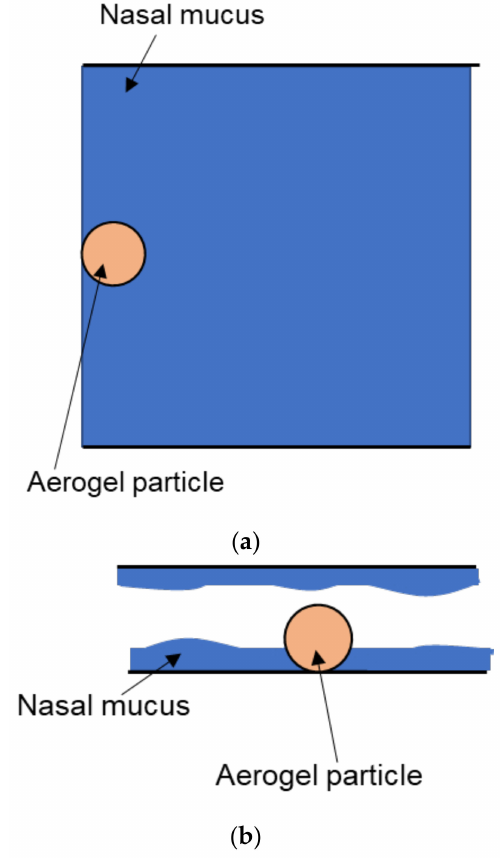
Figure 11. Model nasal cavity with a deposited particle: ( a ) “top view”; ( b ) “profile